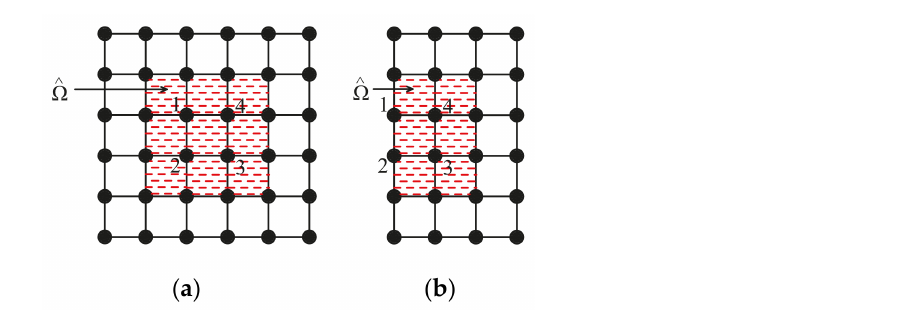
Figure 2. Element support domain: ( a ) central node within computational domain; ( b ) central node on computational